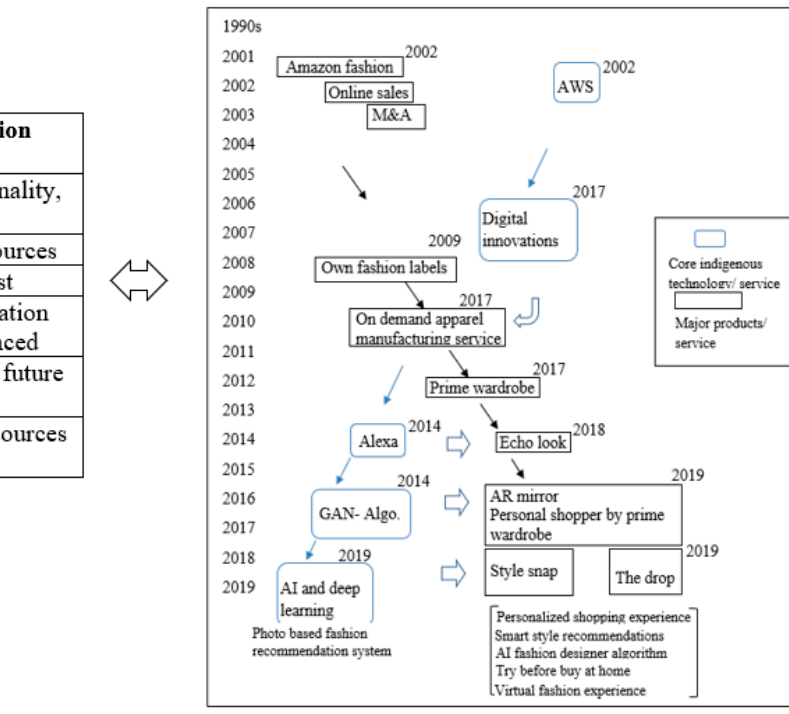
Figure 8. Co-evolution between SIRs-induced innovation and Amazon’s digital fashion business.